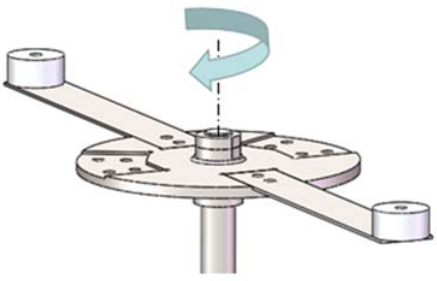
Figure 4. Three-dimensional model of the rotor test stand.